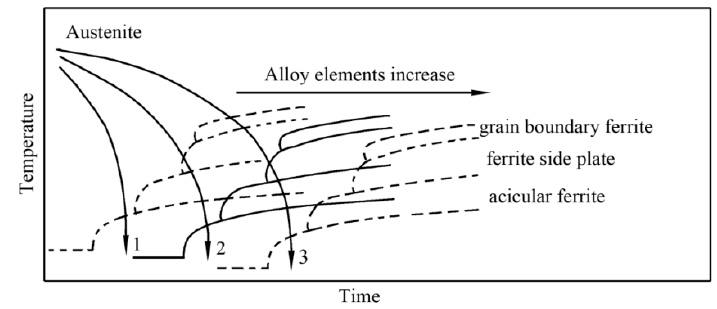
Figure 6. Schematic diagram of the effect of alloy elements on the Continuous Cooling Transformation (CCT) phase diagram.